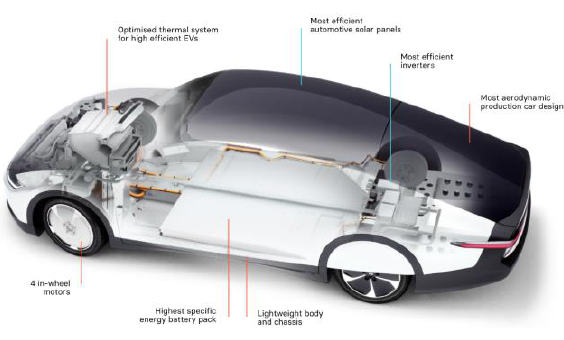
Fig. 12. Lightyear One – main components